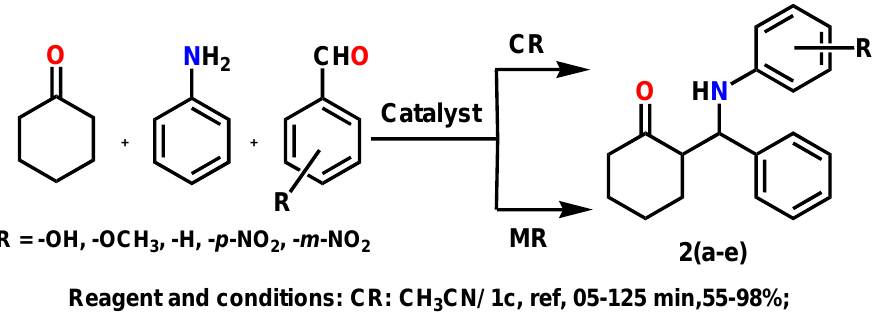
Table 4. Synthesis of β -Amino carbonyl derivatives assisted by various concentrations of metal complex 1 ( a – d